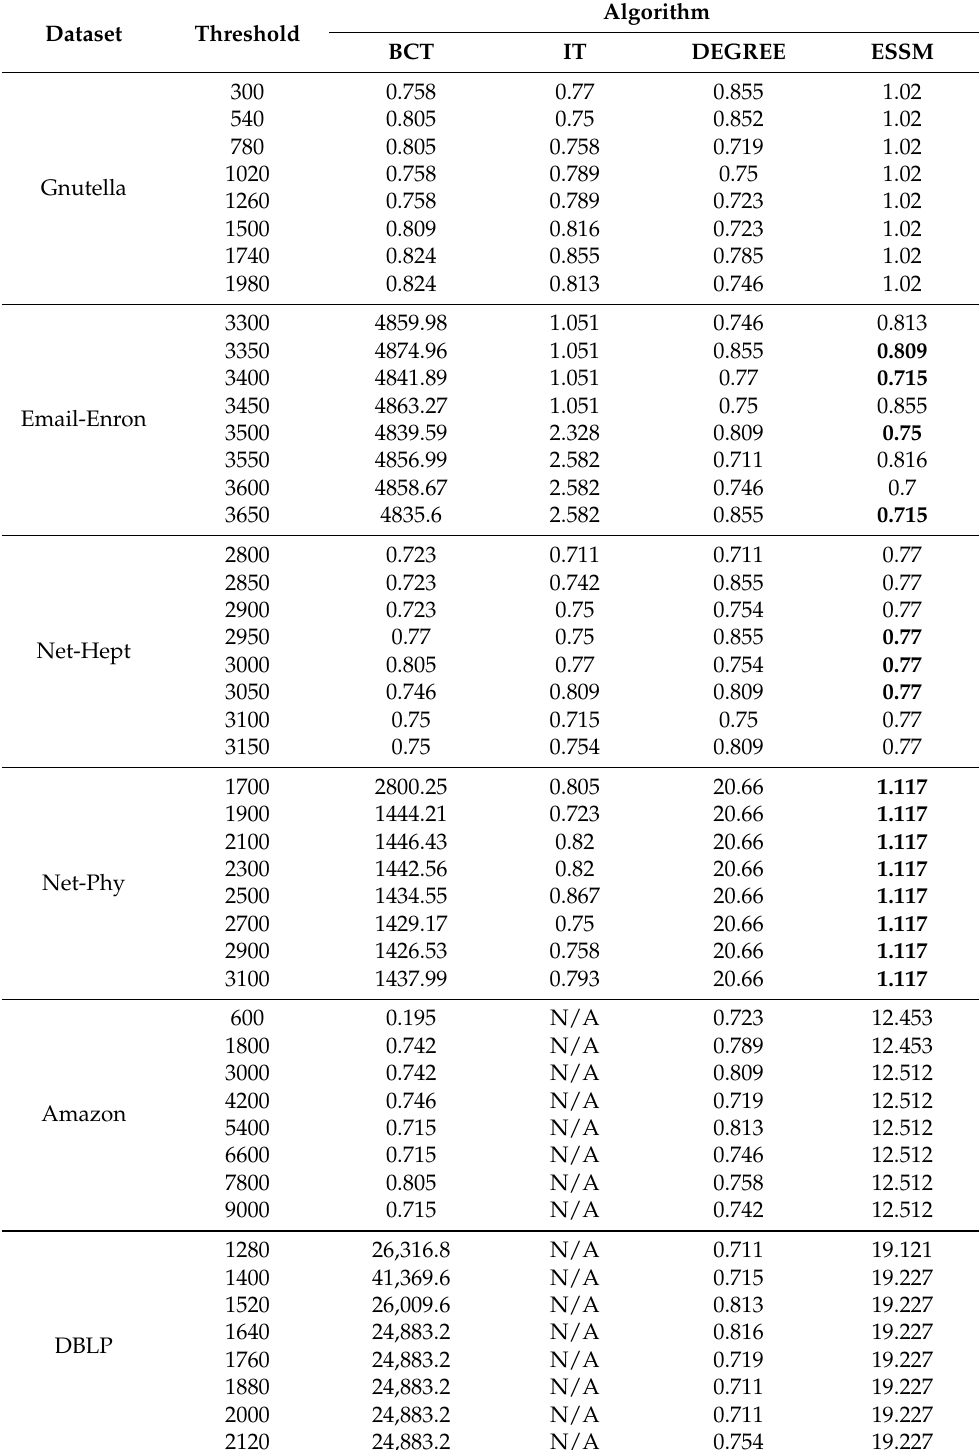
Table 3. Memory usage of compared